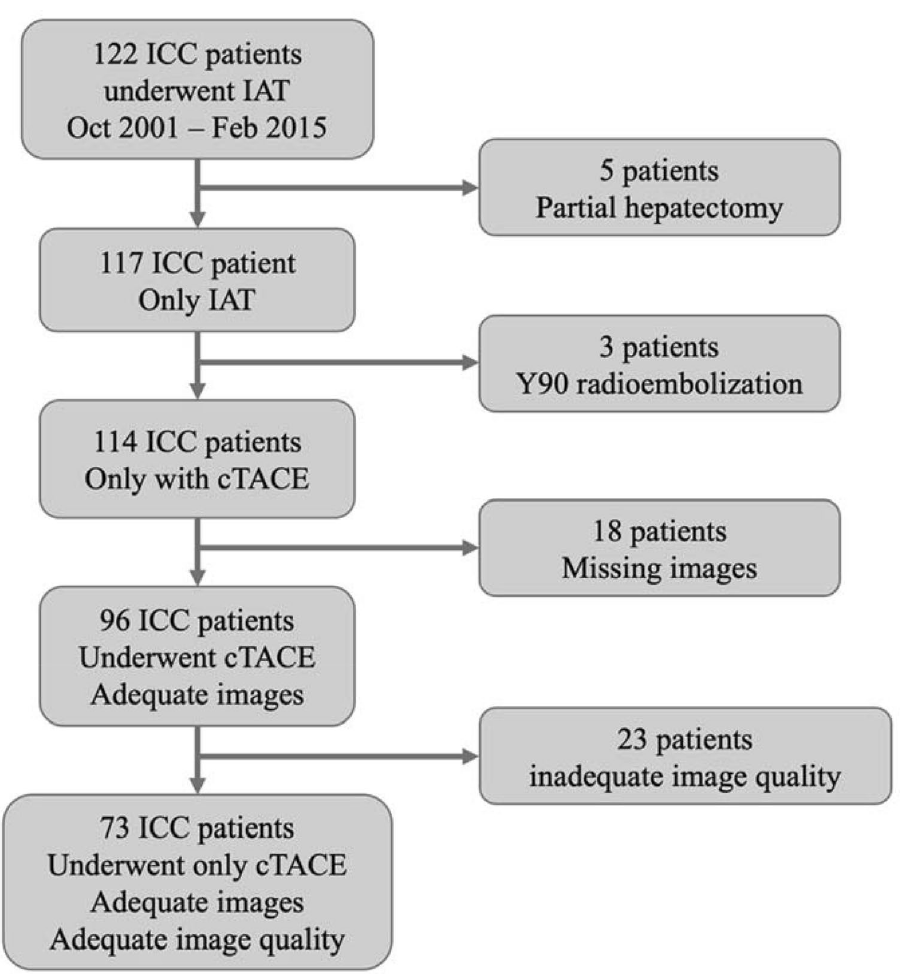
Figure 1. Study flowchart showing number of patients excluded based on exclusion criteria; 73 ICC patients included in the final